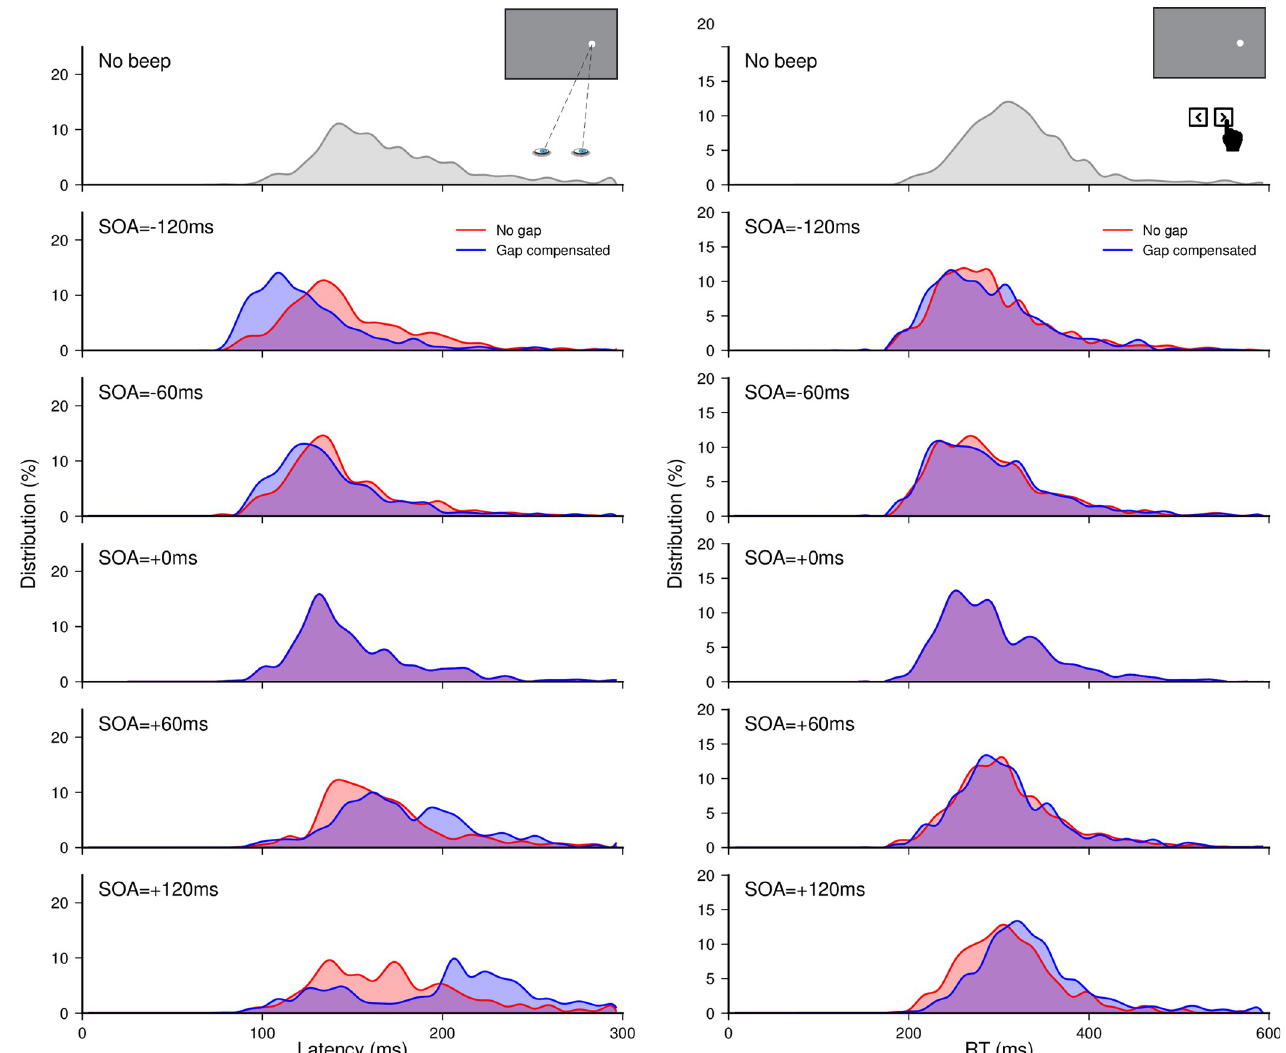
Fig 4. Experiment 1a and 1b. Saccade latency (left) and manual reaction time (right) distributions. Distributions for the No beep condition and for the No gap and Gap compensated conditions plotted for each SOA, with data pooled from all participants.